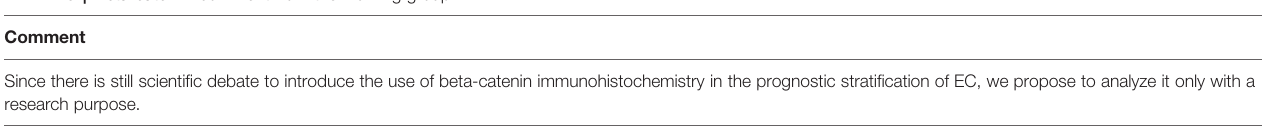
TABLE 7 | PDL1: comments from the working group.